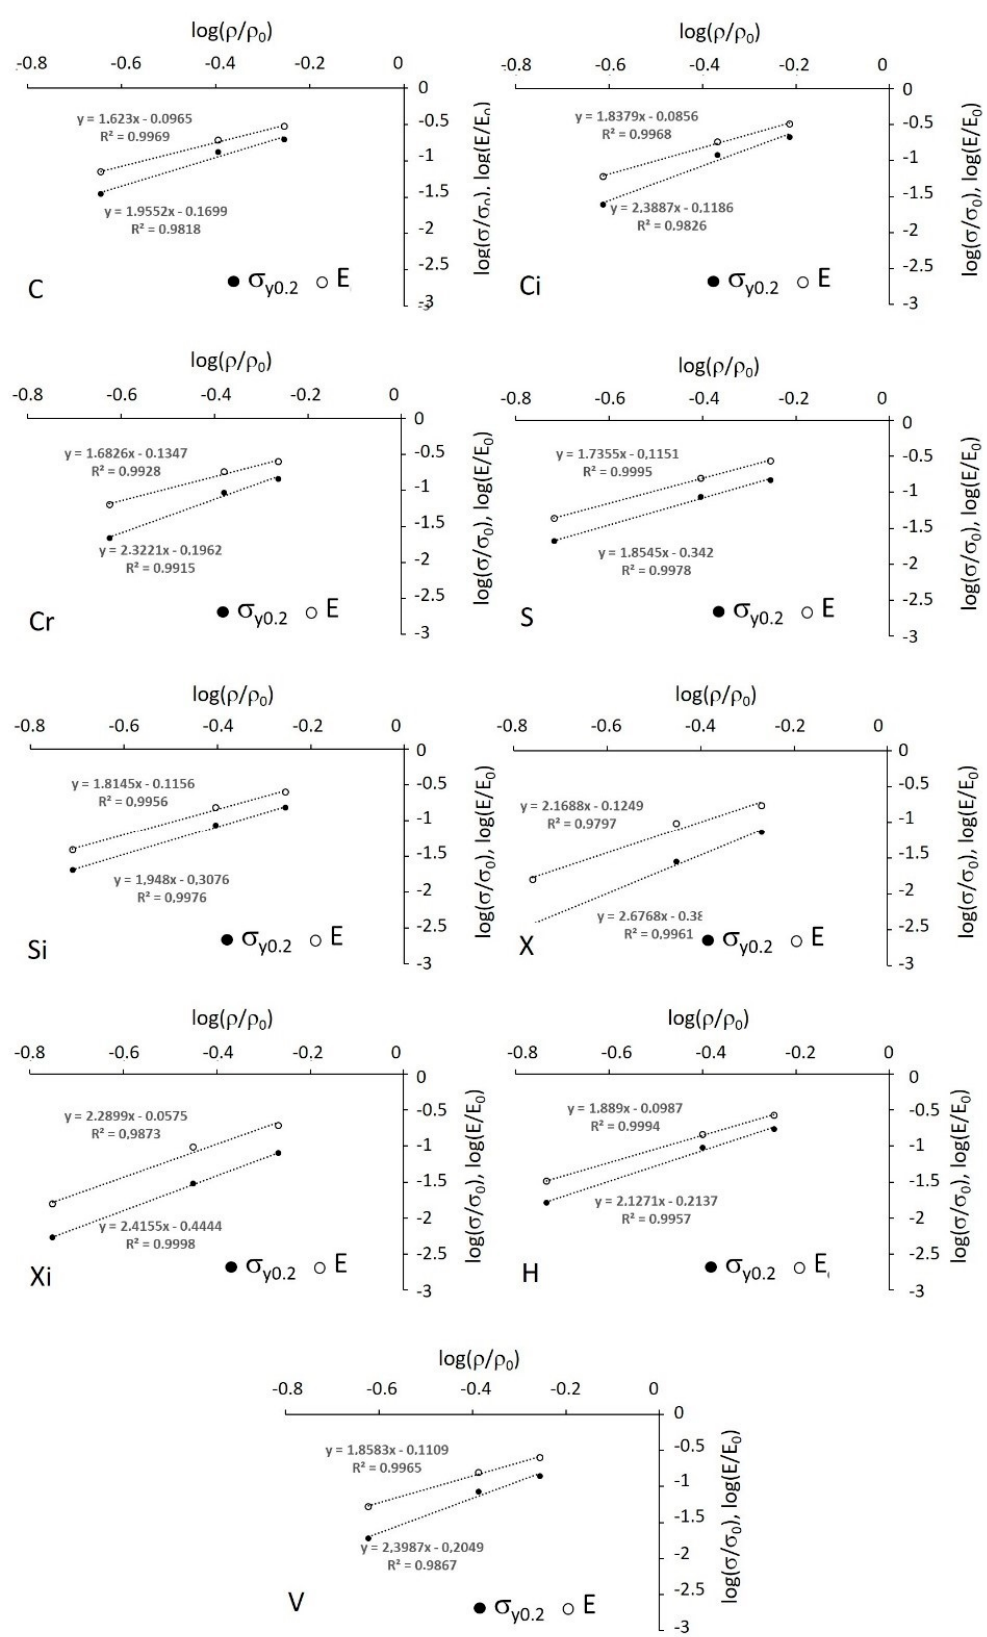
Figure 15. Log–log plot of the Gibson–Ashby model for Young’s modulus and yield strength. The letters refer to